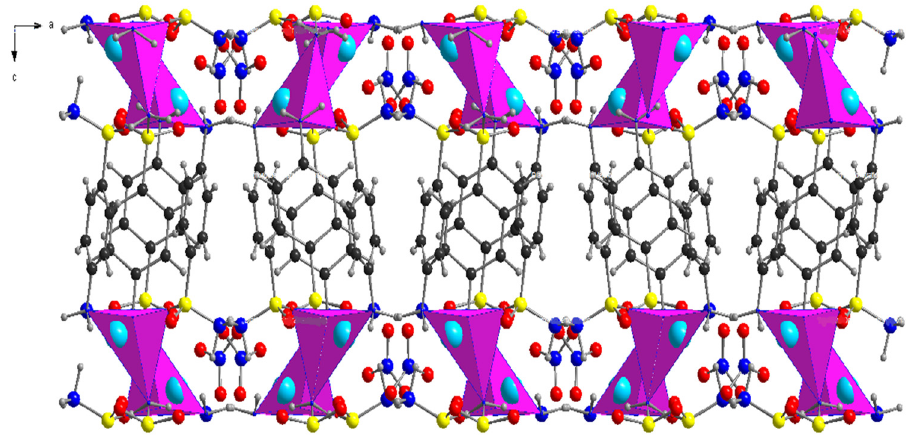
Figure 10: Chaining polyhedra formed by the environment of molybdenum in the plane ( a – c ) .